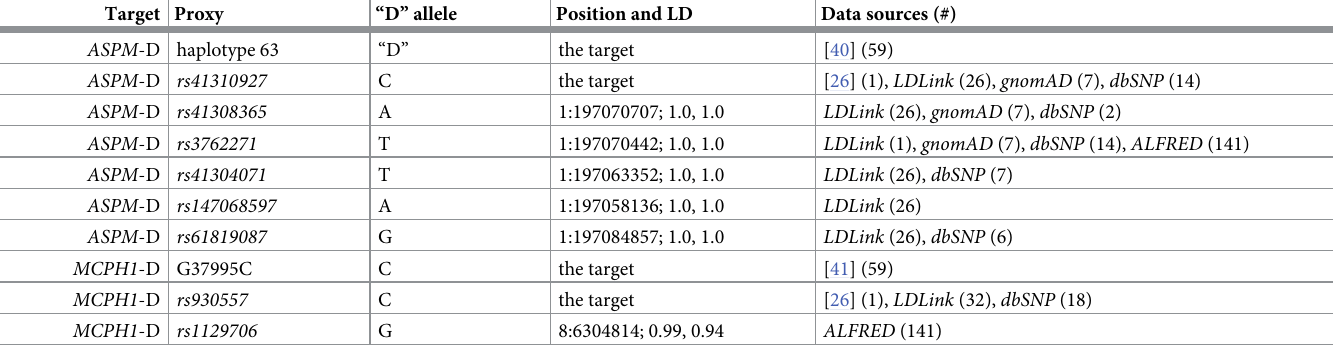
for the list of retained “proxy” SNPs. For ASPM -D, these 5 “proxy” SNPs represent 289 unique extra genetic samples out of 396 (73%), and for MCPH1 -D, the single “proxy” SNPs represents 141 unique extra genetic samples out of 245 (57.6%). Please note that, while increasing the cov- erage of the data, this procedure is not perfect, in that LD may differ between populations and geographic regions, potentially introducing noise. However, running the analyses excluding the “proxy” SNPs produce very similar, but somewhat weaker results to those obtained includ- ing them (see the full HTML analysis report), suggesting that they are, indeed, good proxies for the “derived” alleles. The samples and (meta)populations. The unit (the “group”) for which allele frequency information is given varies between, and even within, these data sources, and cannot be con- sidered a priori equivalent nor unique between and within data sources. For example, 1000 genomes (and LDLink ) contain populations such as “African/African-American”, “Han Chi- nese in Beijing, China” and “Mende in Sierra Leone”, while ALFRED may contain very specific samples from arguably the same (meta)populations, such as SA004380P and SA004595X , both “Khanty”. Thus, I manually matched these units within and between samples using the meta-information available in each database, resulting in 175 unique samples contained in 129 unique (meta)populations , where possible based on those available in ALFRED ; each sample has a unique ID , while for each (meta)population, besides a unique ID , I also provide a “read- able” name. With these, a (meta)population may contain one or more samples: e.g., “Abkhaz” [ PO000844Q ] contains just the ALFRED sample SA004584V , while “Adygei” Table 2. The original loci and their “proxy” SNPs, with their “derived” allele and the data sources (with the number of unique samples/populations) from which fre- quency information was obtained. Target